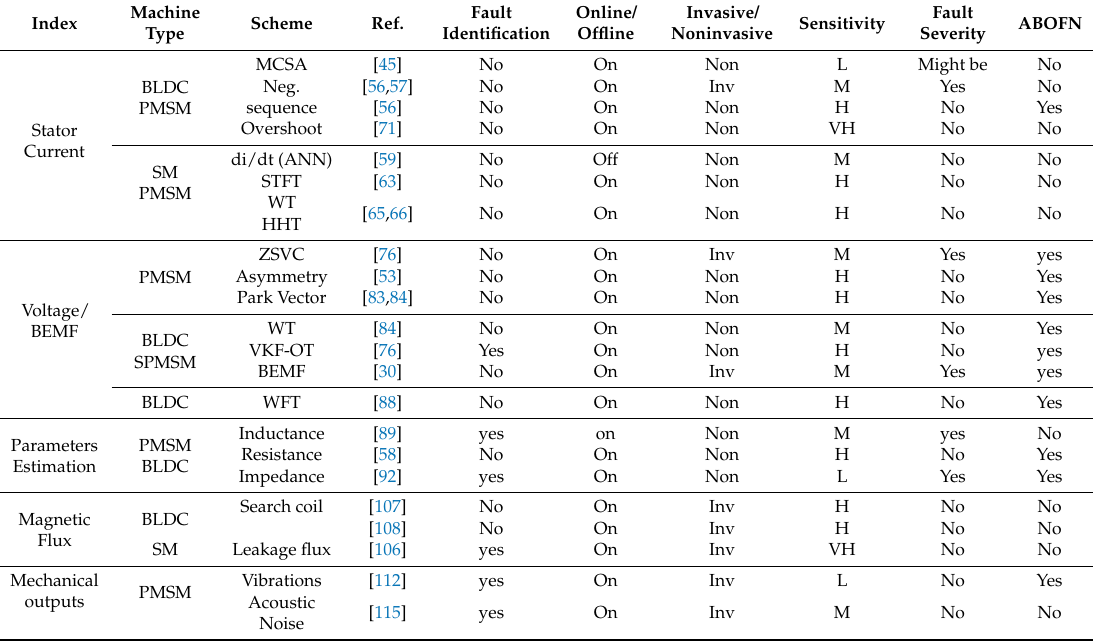
Table 1. Strengths and weaknesses of the fault diagnosis techniques in PM-type machines under ITSF.